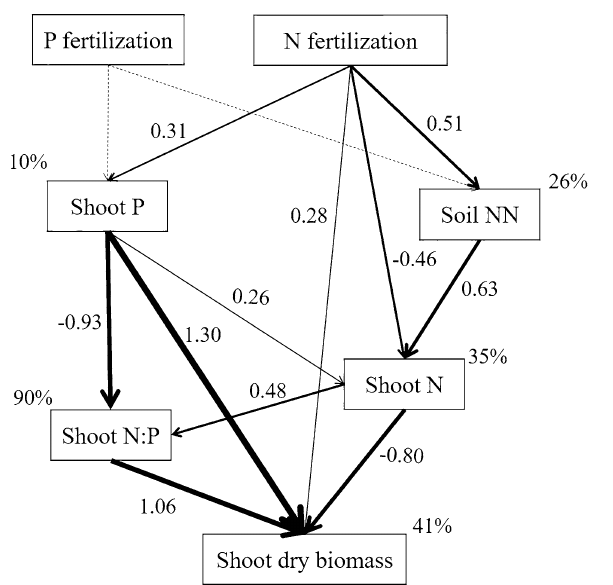
Figure 2. Structural equation models for the paths of N and P fertilization affecting soil and shoot N and P nutrients, stoichiometry and shoot dry biomass. The final models fitted the data well: χ 2 = 7.442, df = 4, χ 2/ df = 1.861, P = 0.114, GFI = 0.954, RMSEA = 0.135; the solid arrows indicate significant positive relations ( P < 0.05), and the dashed arrow indicates no relation. Numbers near the arrows are the standardized path coefficients and the width of the arrows is proportional to the strength of the relationship. The percentages near the endogenous variables indicate the variance explained by the model ( R 2